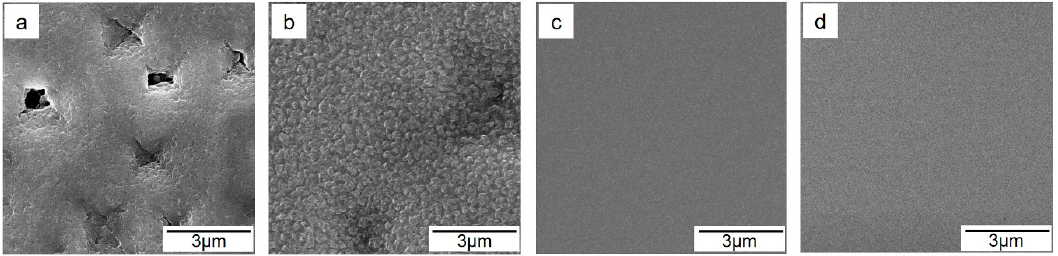
Figure 5. Scanning electron microscopy (SEM) micrographs of the samples grown with di ff erent CH 4 Figure 5. S canning electron microscopy (SEM) micrographs of the samples grown with different CH 4 flow ratios. ( a ) 3%, ( b ) 4%, ( c ) 5%, and ( d ) flow ratios. ( a ) 3%, ( b ) 4%, ( c ) 5%, and ( d ) 6%.